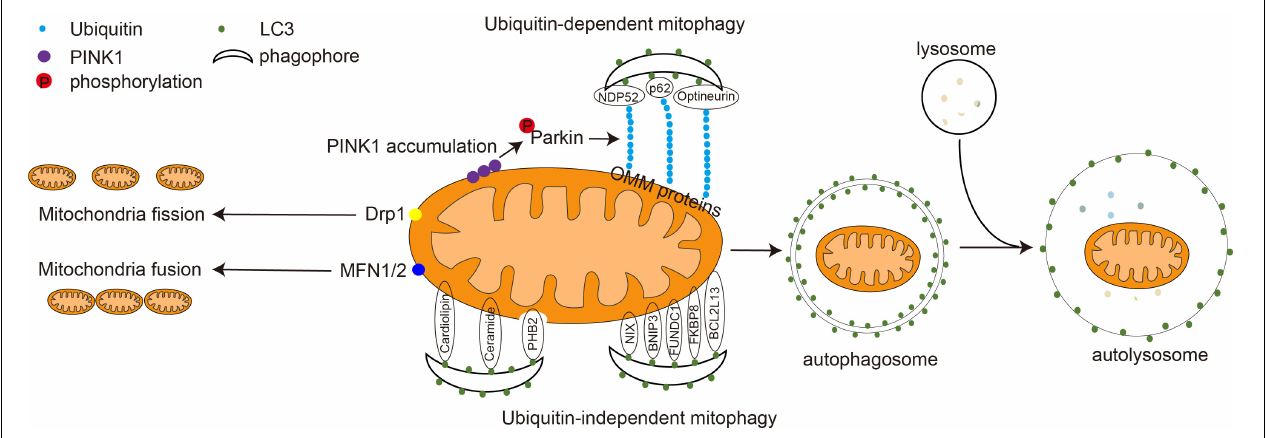
FIGURE 1 | Mitochondrial dynamics and the molecular mechanism of mitophagy. In the physiological state, mitochondria fuse to form a tubular structure via the action of MFN1 and MFN2. In the pathological state, mitochondria are damaged and split into smaller granular mitochondria via the action of Drp1. The damaged mitochondria are degraded through either ubiquitin-dependent or ubiquitin-independent mitophagy. During ubiquitin-dependent mitophagy, PINK1 accumulates on the mitochondrial outer membrane, recruiting and activating the E3 ligase Parkin. Parkin ubiquitinates mitochondrial outer membrane proteins, including MFN1 and MFN2. The mitophagy adapter proteins p62, NDP52, and optineurin connect LC3 to ubiquitinated proteins on the OMM and guide mitochondria into the phagophore. In ubiquitin-independent mitophagy, mitophagy OMM receptors such as NIX, BNIP3, FUNDC1, BCL2L13, FKBP8, and IMM receptor PHB2, as well as mitochondrial lipids, including cardiolipin and ceramide, interact with LC3 directly. The phagophore gradually expands to form a double-layered autophagosome. Autophagosomes and lysosome fuse to form a single-layer-membrane-wrapped autolysosome to degrade and recycle the damaged mitochondrial